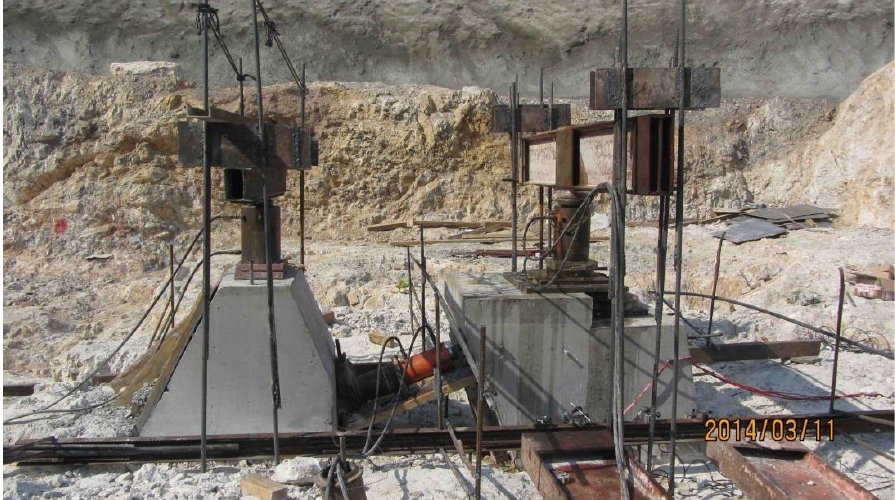
Figure 6. The in-situ scale model test of the bridge anchorage.